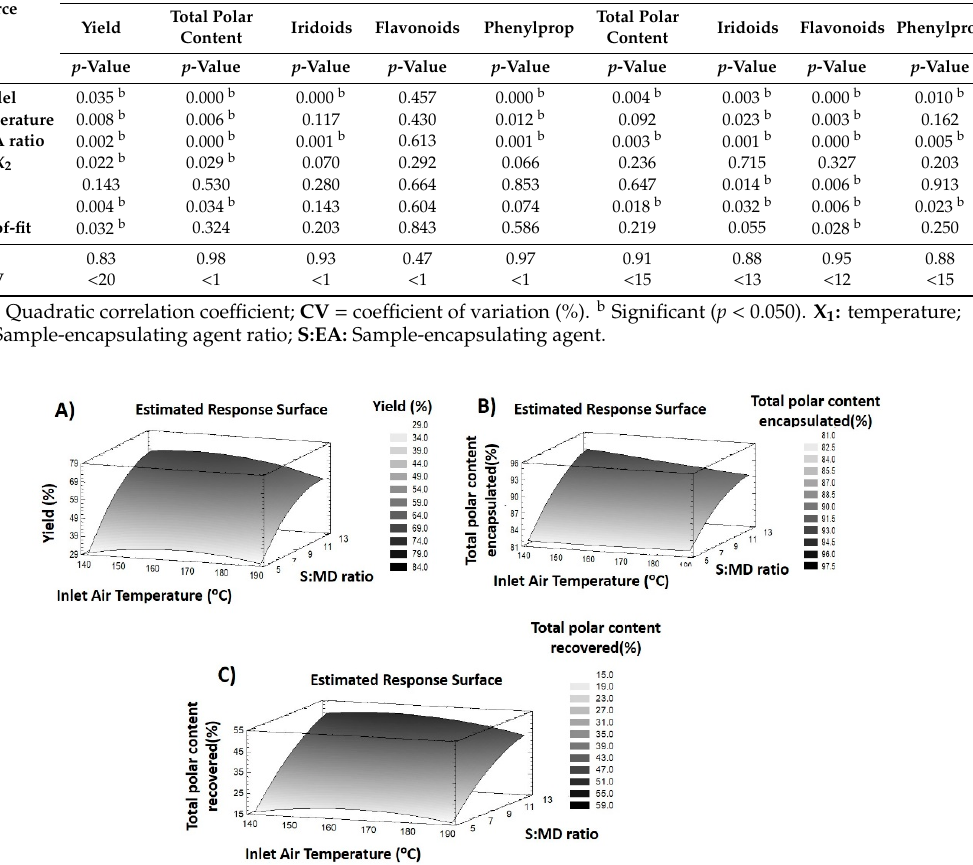
Table 4. Analysis of variance (ANOVA) of the regression models. Response variables: Yield, encapsulation and recovery of total polar content and both chemical group in inulin microparticles. Source